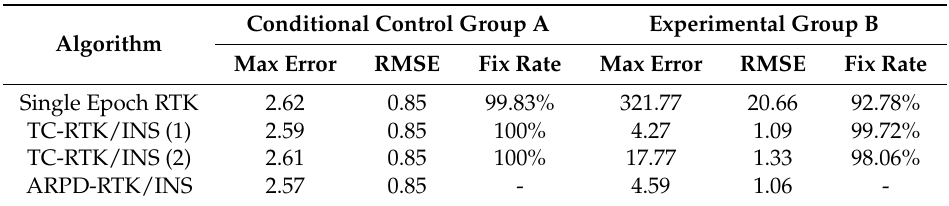
Table 2. Trajectory error and fix rate for different RTK algorithms with small pseudorange errors (Unit: cm). RMSE: root mean square